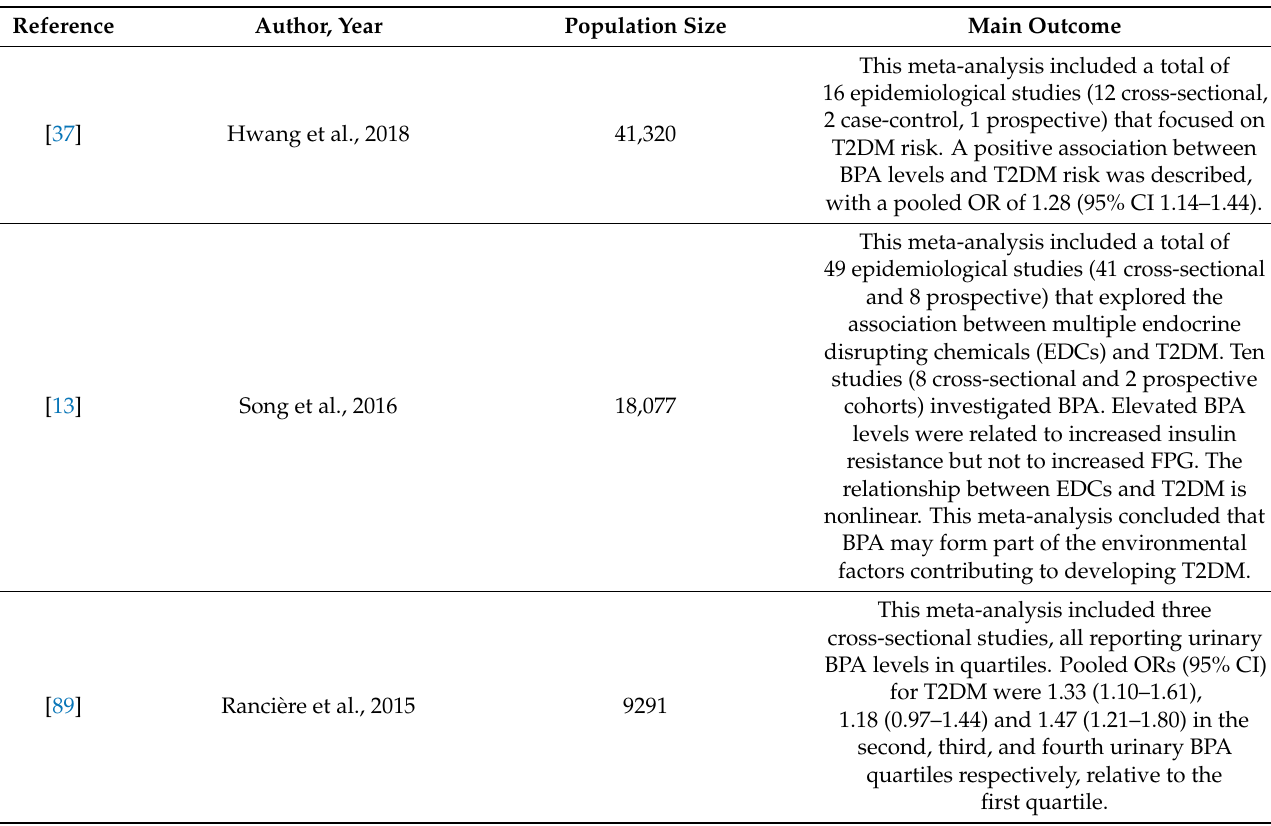
Table 2. Summary of the main findings of the meta-analyses investigating the association between BPA and